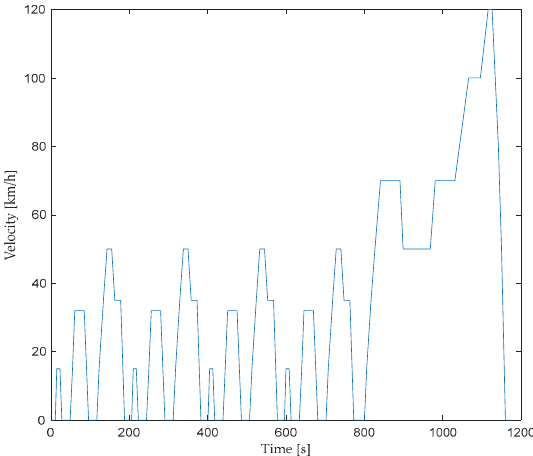
Figure 5. New European driving cycle (NEDC).